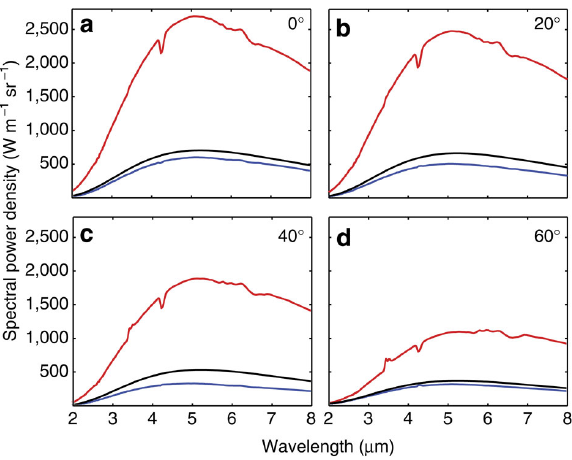
Figure 5: Emitted power spectra measured at 553 K for different col- lection angles. Red and blue lines are for the carbon dot with and without the hemispherical dome, respectively. Black lines are emis- sion power from an ideal blackbody of the same area as the carbon dot at the same temperature. The ripples in the curves are caused by atmosphere absorption. (a), (b), (c), and (d) are measured at 0 degrees, 20 degrees, 40 degrees, and 60 degrees, respectively [8].